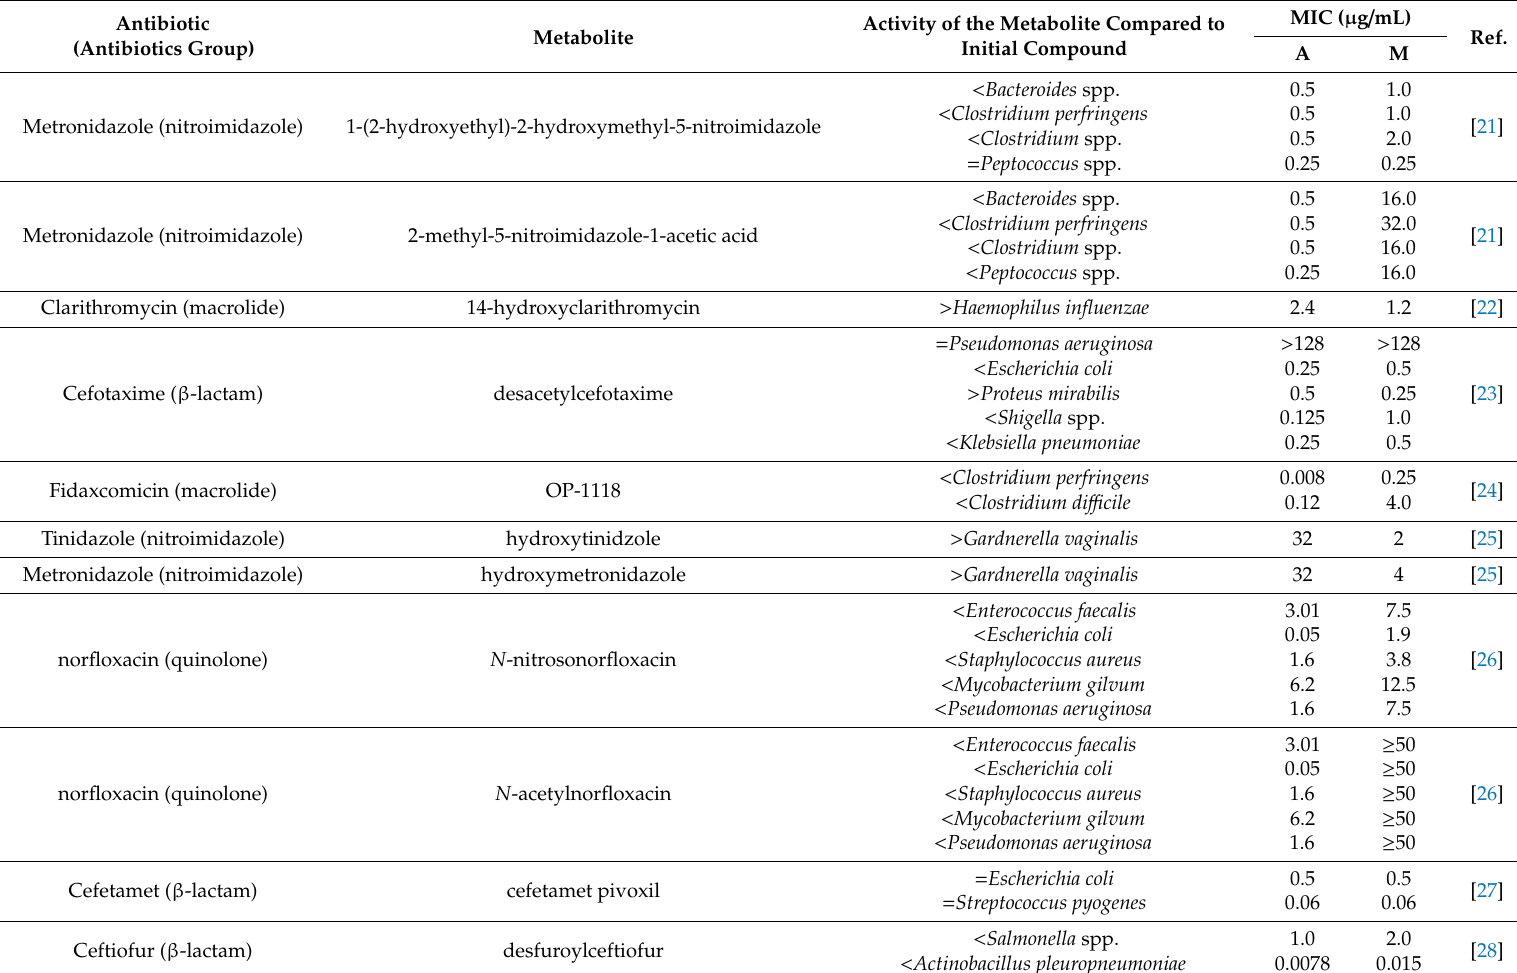
Table 1. The antibacterial activity of selected antibiotic